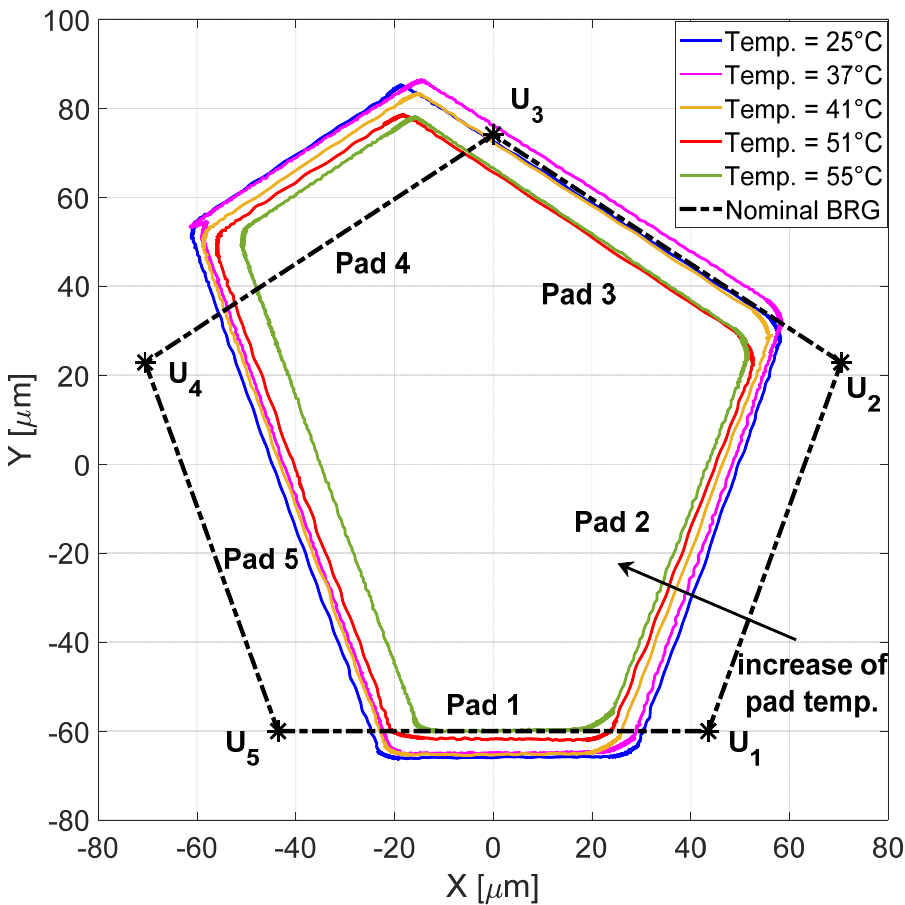
Figure 11. Measured clearance profiles at different pad temperatures and the predicted nominal clearance profile.